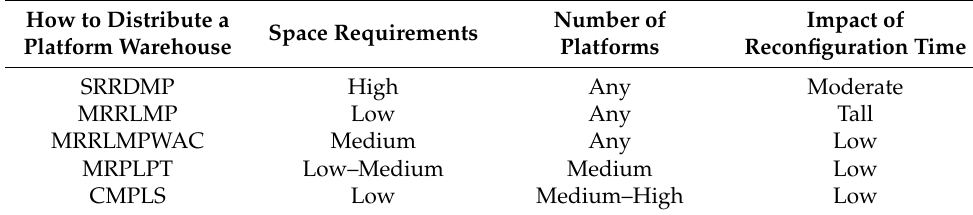
Table 3. The effect of a modular platform warehouse